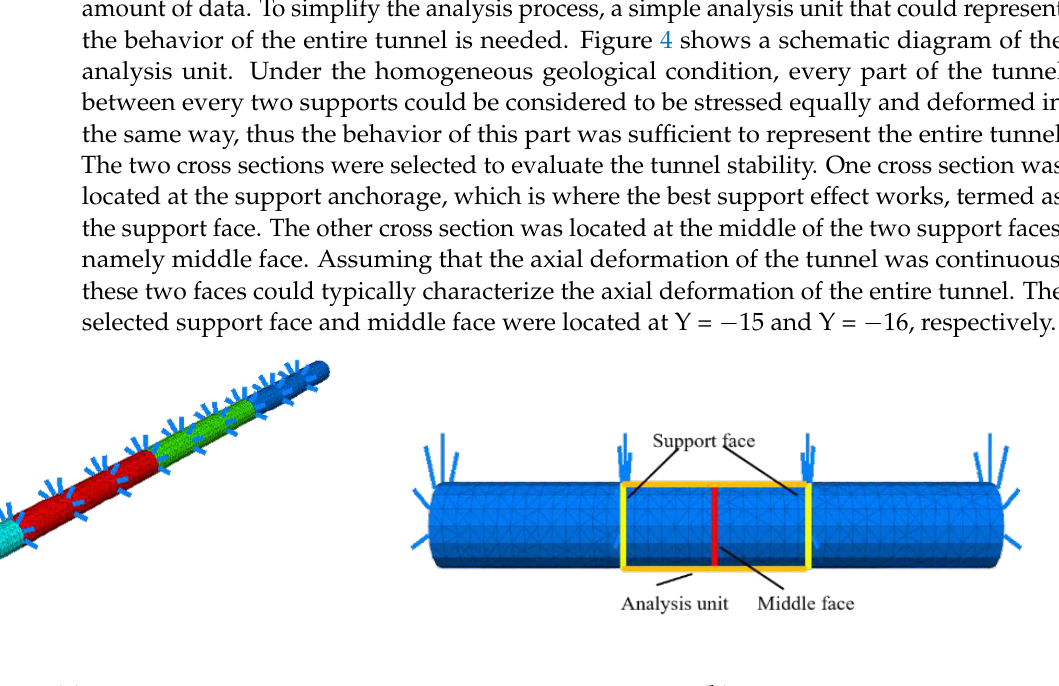
Table 4. Material property values used for rock bolt.